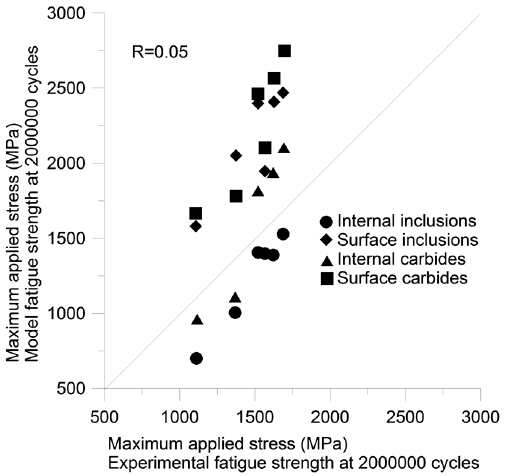
Figure 10. Failure reasons at various experimental strengths after ref. [23].